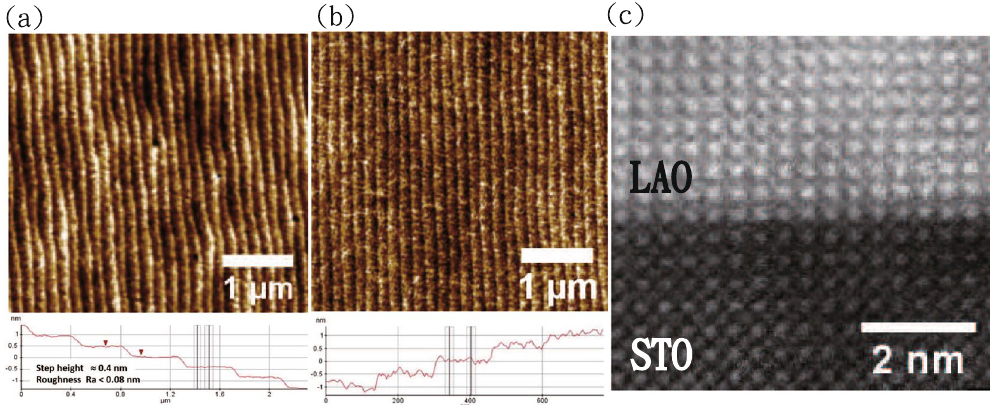
Figure 2. AFM images of a TiO 2 -terminated STO substrate before ( a ) and after ( b ) growth of 20-uc LAO film for La/Al ratio = 1.0 sample. Lower panels show the cross-sectional profiles of the atomic steps on the surface of samples. No significant change in the roughness and terraces is observed indicating the great smoothness and uniformity of the LAO films, which is also confirmed from the atomic structure revealed by the STEM image across the LAO/STO interface as shown in ( c ).